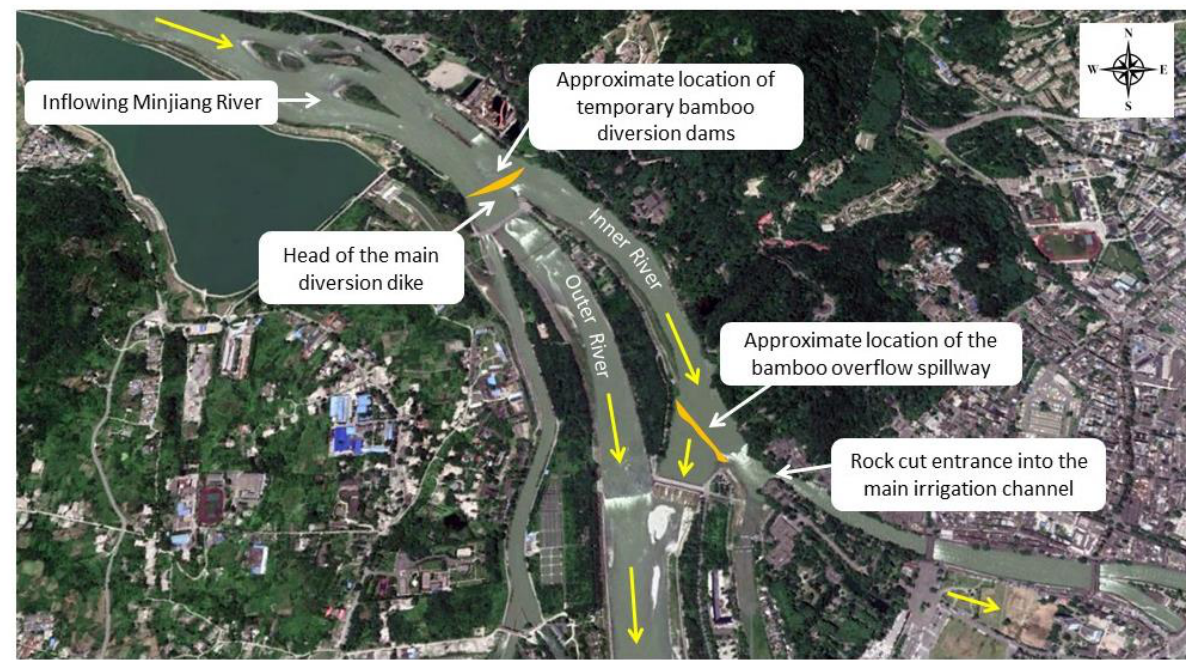
Figure 3. Schematic configuration of the early Dujiangyan irrigation headworks overlaid on a 2018 Google Earth image of the site. Temporary bamboo dams above the main diversion dike were used to divert the inflowing water into an outer river that bypassed the entrance of the irrigation channel and an inner river that approached it. An overflow spillway was used to regulate the amount of water entering the irrigation channel and help prevent buildup of sediments.